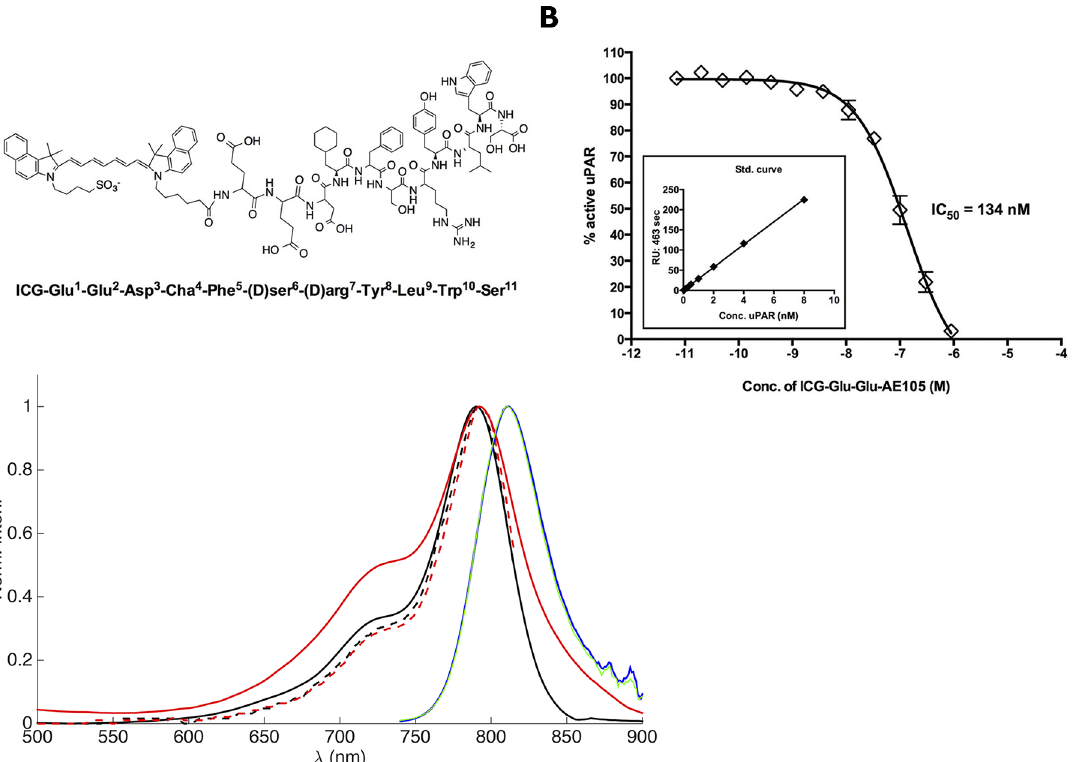
Fig 1. Structure and binding affinity for ICG-Glu-Glu-AE105. (A) The chemical structure of ICG-Glu-Glu-AE105 (B) Assessing uPAR binding properties of ICG-Glu-Glu-AE105 by an indirect solution competition for uPA binding by surface plasmon resonance yielding an IC 50 value of 134 nM. (C) Absorption spectra of ICG (black, full line) and ICG-Glu-Glu-AE105 (red, full line) measured in HBC solution. Ecitation spectra of ICG (black, broken line) and ICG-Glu- Glu-AE105 (red, broken line) measured in HBC solution. Fluorescence spectra of ICG (blue) and ICG-Glu-Glu-AE105 (green) measured in HBC solution. The noise observed between 860 – 900 nm in the fluorescence spectra are due to poor detector correction of the instrument in this